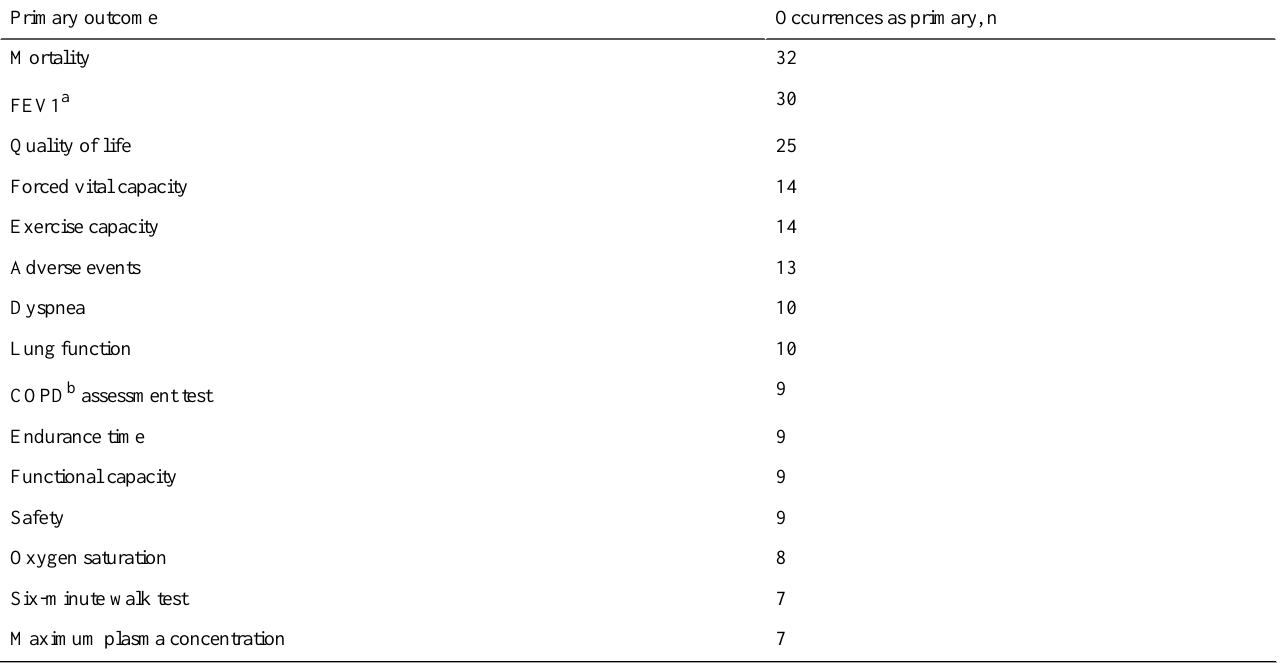
Table 2. Top 15 primary outcomes identified by the pipeline for chronic obstructive pulmonary disease.